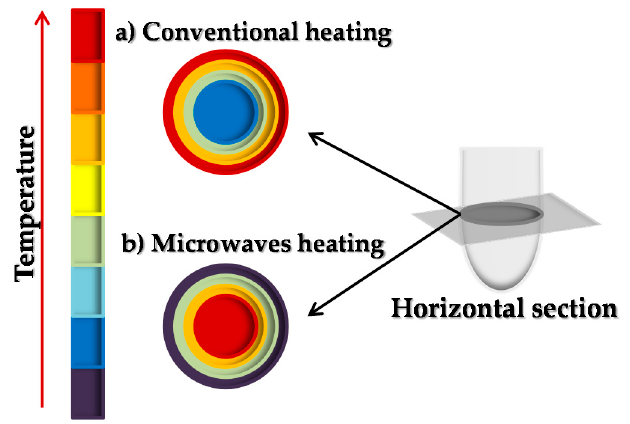
Figure 1. Temperature profiles provided by ( a ) conventional heating or ( b ) microwave-assisted processes.